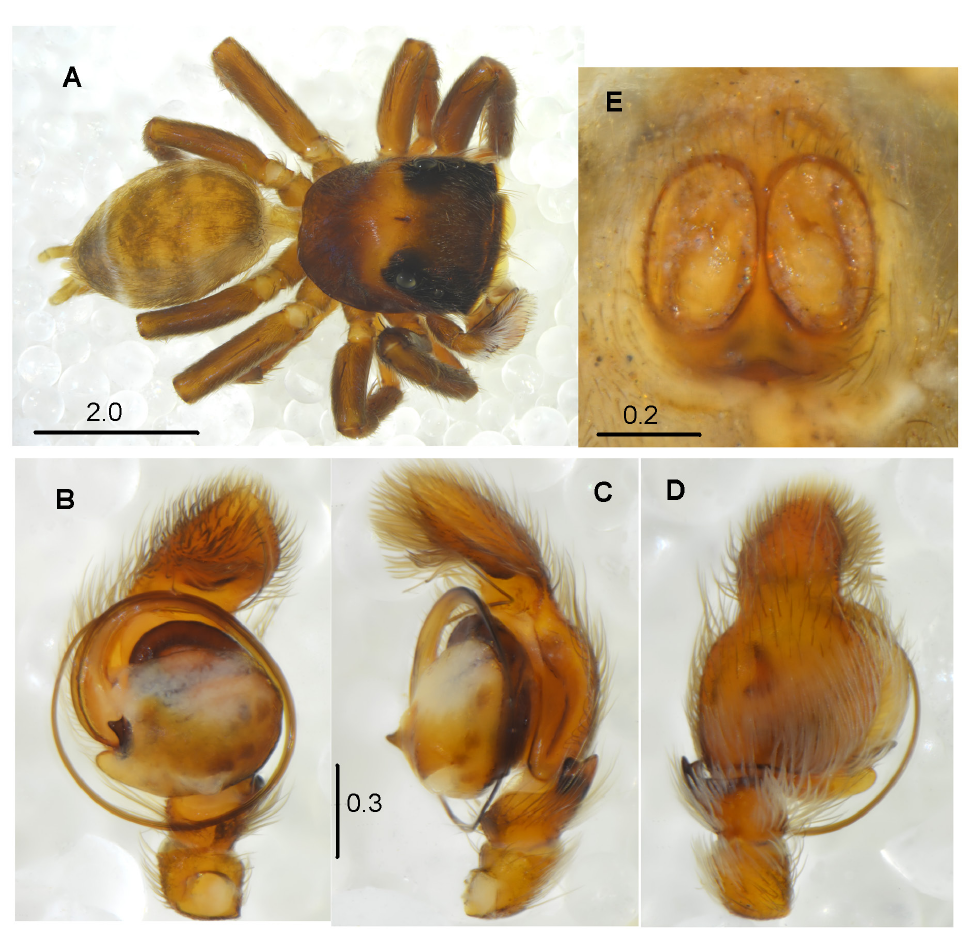
Fig. 7. Bacelarella tanohi Szűts & Jocqué, 2001, ♂♀ (MNHN). A . Male habitus, dorsal view. B . Palpal organ, ventral view. C . Palpal organ, ventrolateral view. D . Palpal organ, dorsal view. E .